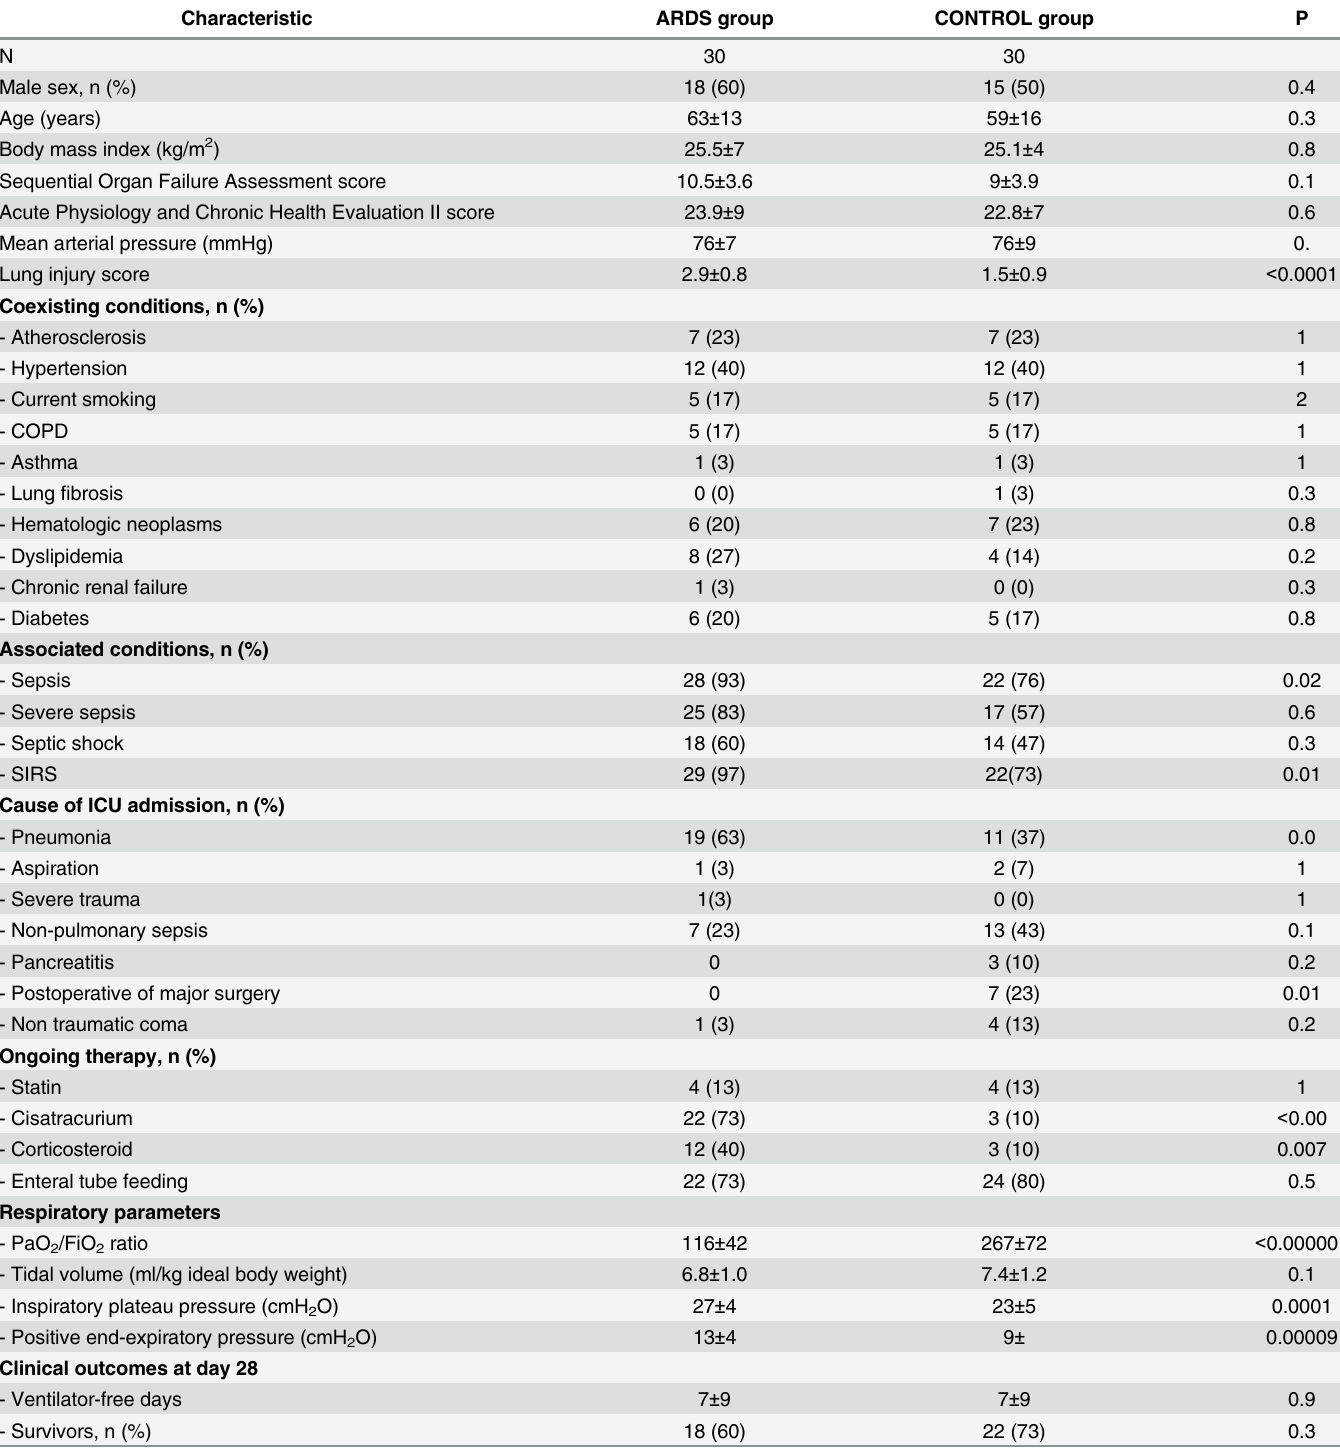
Table 1. Baseline characteristics of the patients. Data are expressed as means ± standard deviations, unless otherwise indicated. The body-mass index is the weight in kilograms divided by the square of the height in meters. Lung injury (or Murray) score can range from 0 to 4, with higher values indicating more severe injury. Percentages may not exactly total 100% because of